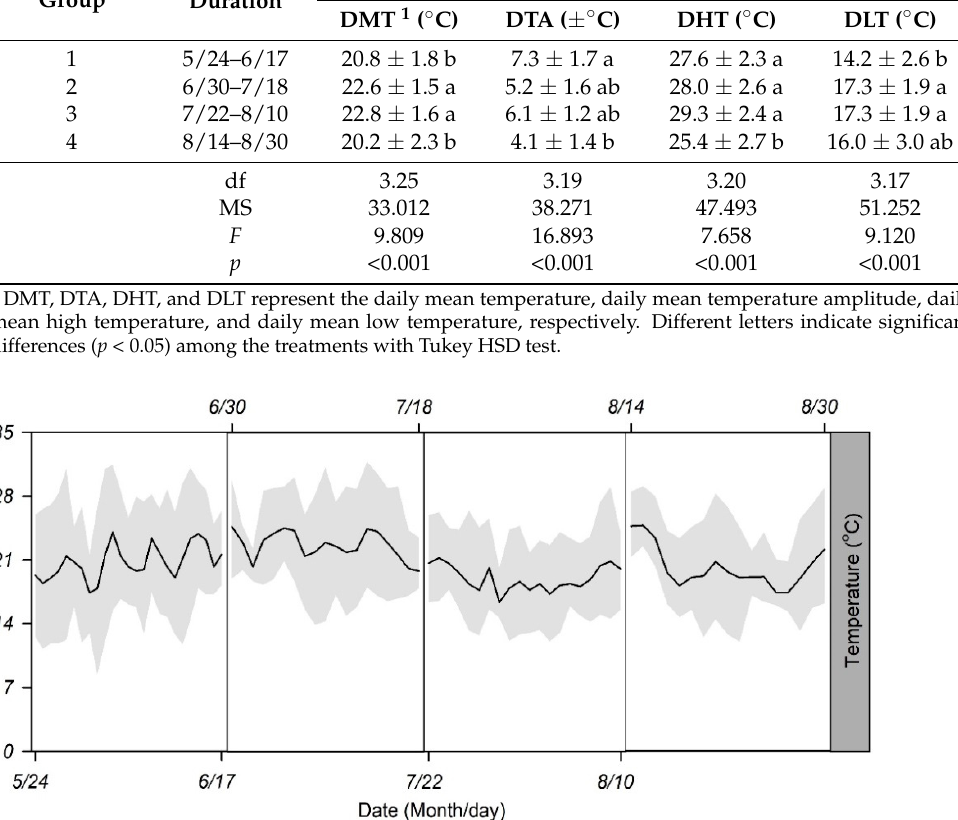
Table 1. Actual recorded ambient temperatures (mean ± SD) in different treatment groups. Group Duration Actual Recorded Temperature DMT 1 ( ◦ C) DTA ( ± ◦ C)